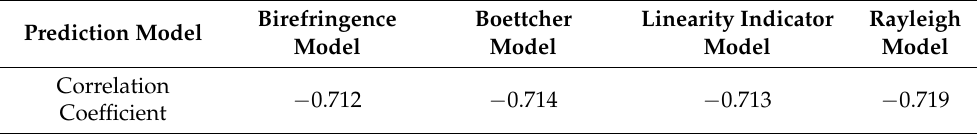
Table 7. Correlation coefficient of the predicted density with the measured